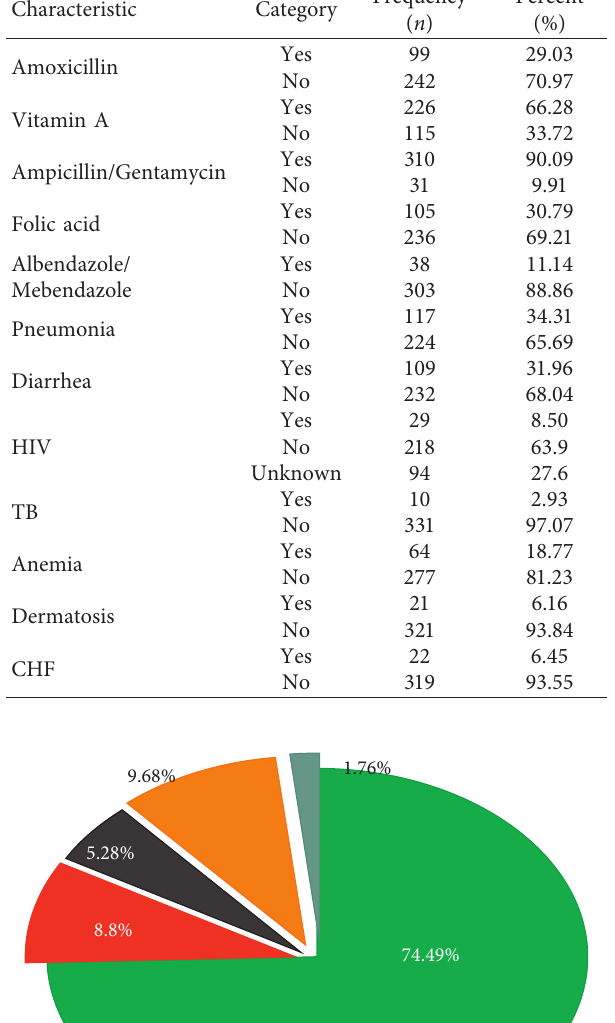
Table 2: Routine medications and complications of children 6–59 months admitted with SAM to East Amhara Public Hospitals, 2019.